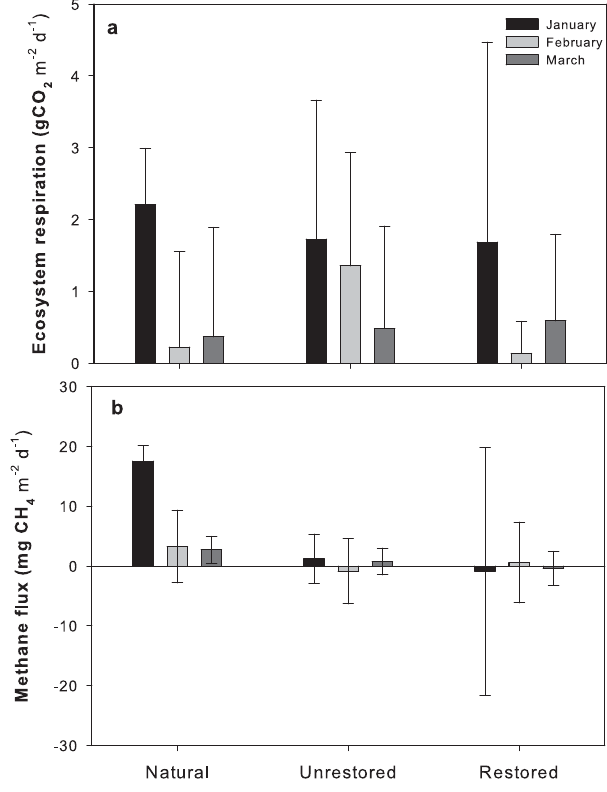
Fig. 4. Non-growing season ecosystem respiration (a) and methane flux (b) at natural, unrestored and restored field plots. Error bars give standard deviation of the mean.